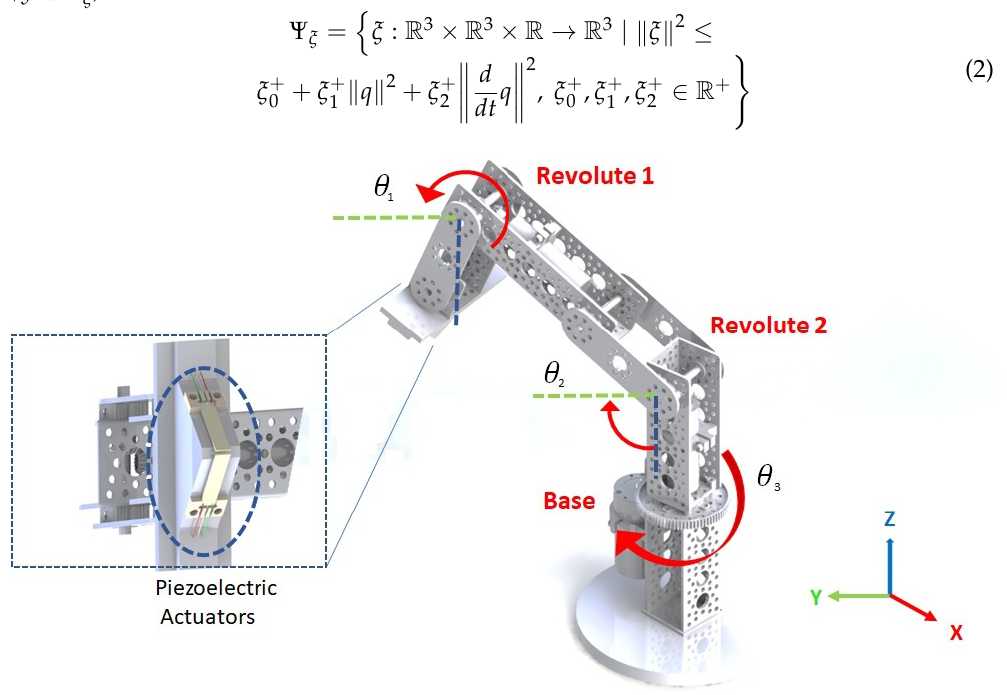
Figure 1. Description of the robotic arm and the gripping device based on bimorph piezoelectric